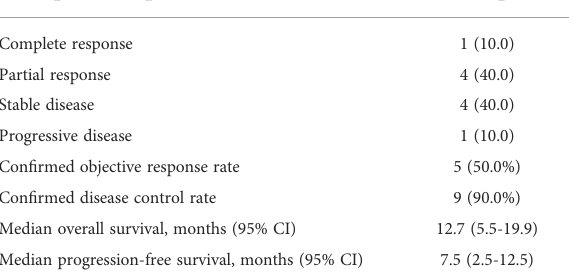
TABLE 3 Clinical antitumor